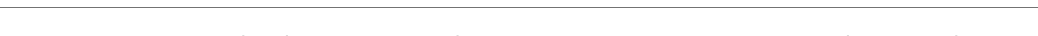
Table 1 | Patient details, including medication type (Med), medication dose (Dose; chlorpromazine equivalent in mg/day), diagnosis (SZ, schizophrenia; PS, paranoid schizophrenia), intelligence quotient (I.Q.), total scores on tPANSS, scores for the positive symptoms of the PANSS test (tPSS), scores for the negative symptoms of the PANSS test (tNSS), scores for the general symptoms of the PANSS test (tGSS), scores on a cognitive factor which overlaps heavily with the concept of disorganization syndrome (tDIS) and scores for item P2 on the PANSS test, “conceptual disorganization”